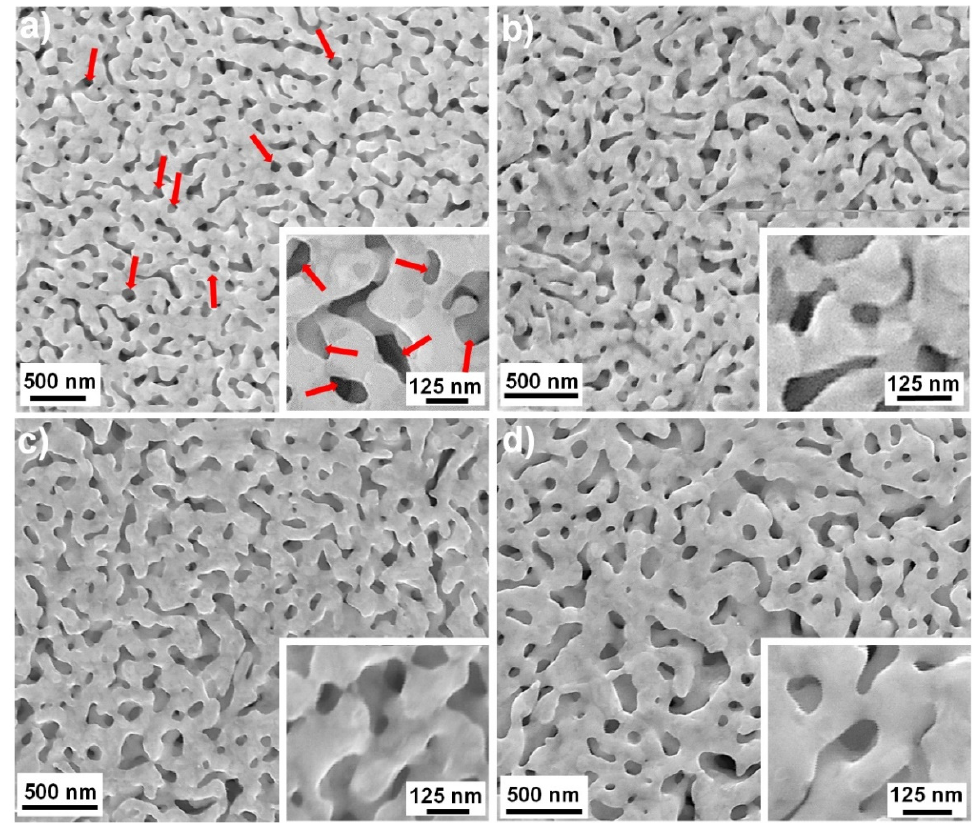
Figure 3. SEM-SE images of the surface view of ( a ) NPG_8h, ( b ) NPG_12h, ( c ) NPG_14h, and ( d ) NPG_16h.